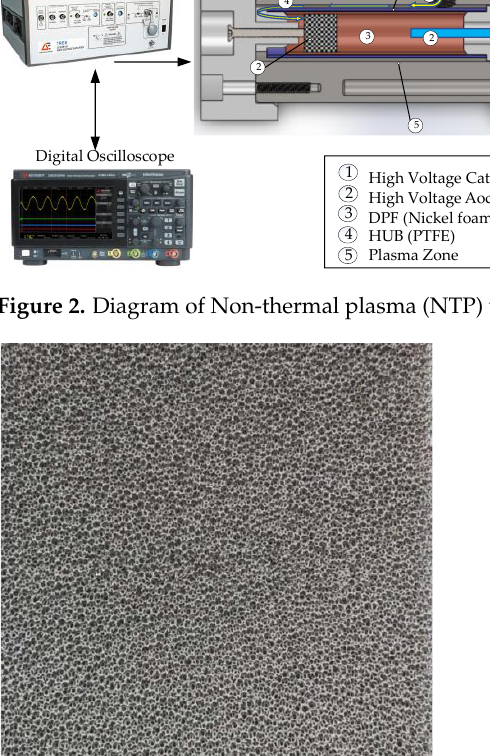
Figure 3. The Porous Material.